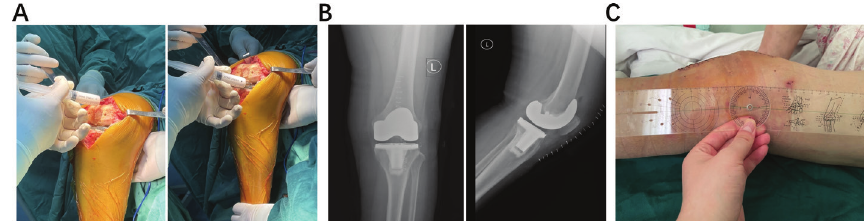
Fig. 2 . (A) Cocktail injection of tissue around the joint cavity. (B) Frontal and lateral of knee X-ray after total knee arthroplasty. (C) Postoperative knee joint extension